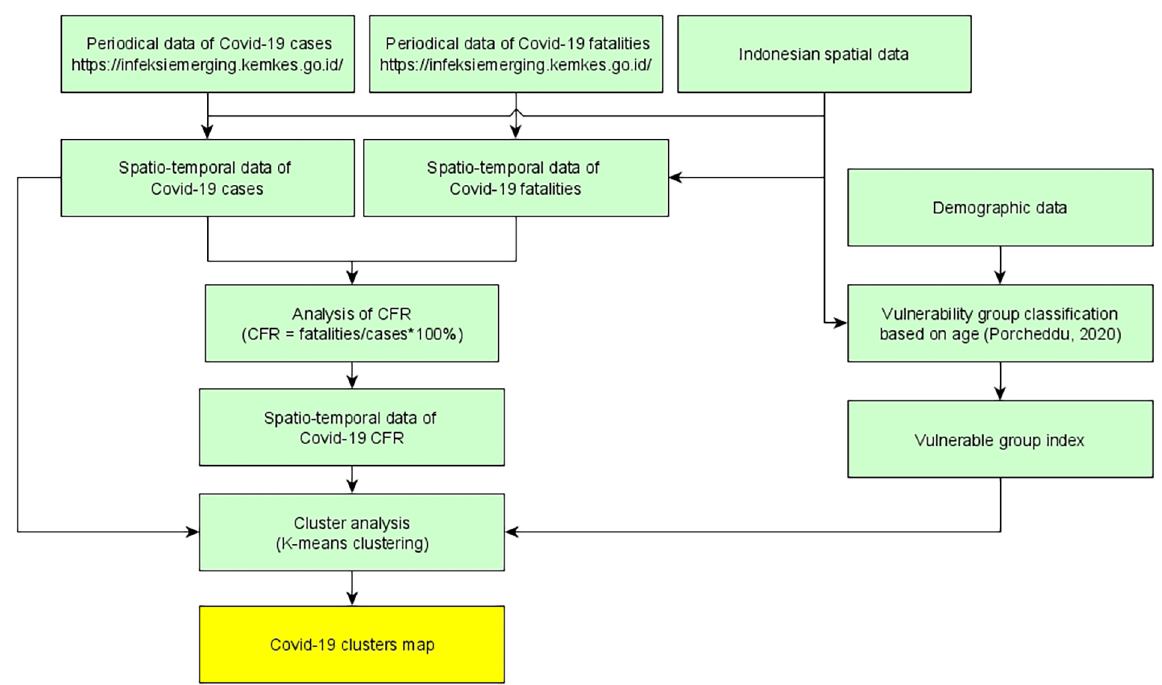
Fig. 2. The general framework of the study. Source: own